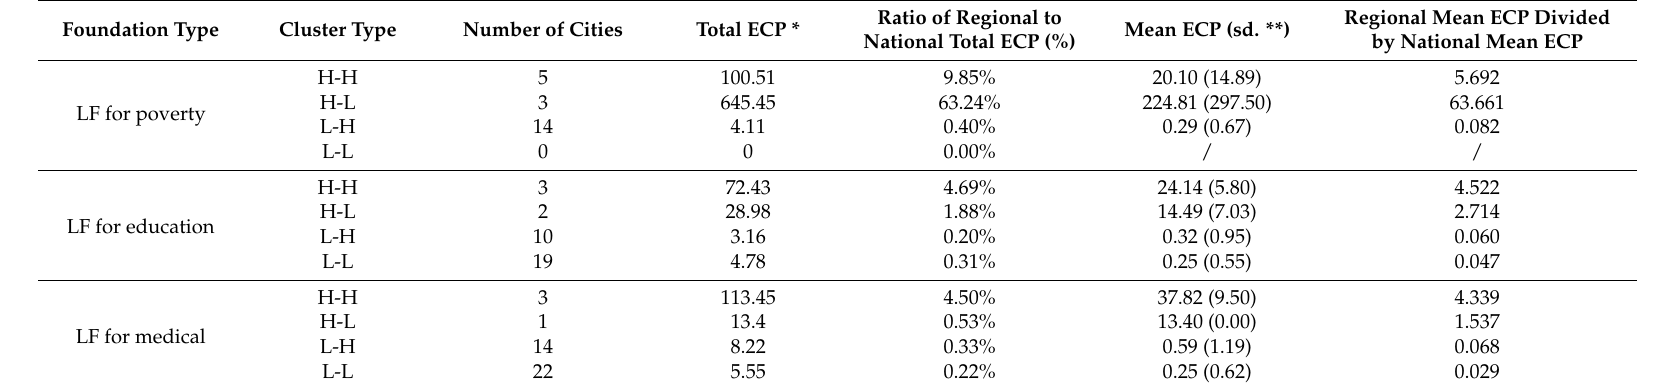
Table 3. Statistical summary of charity expenditures in local cluster